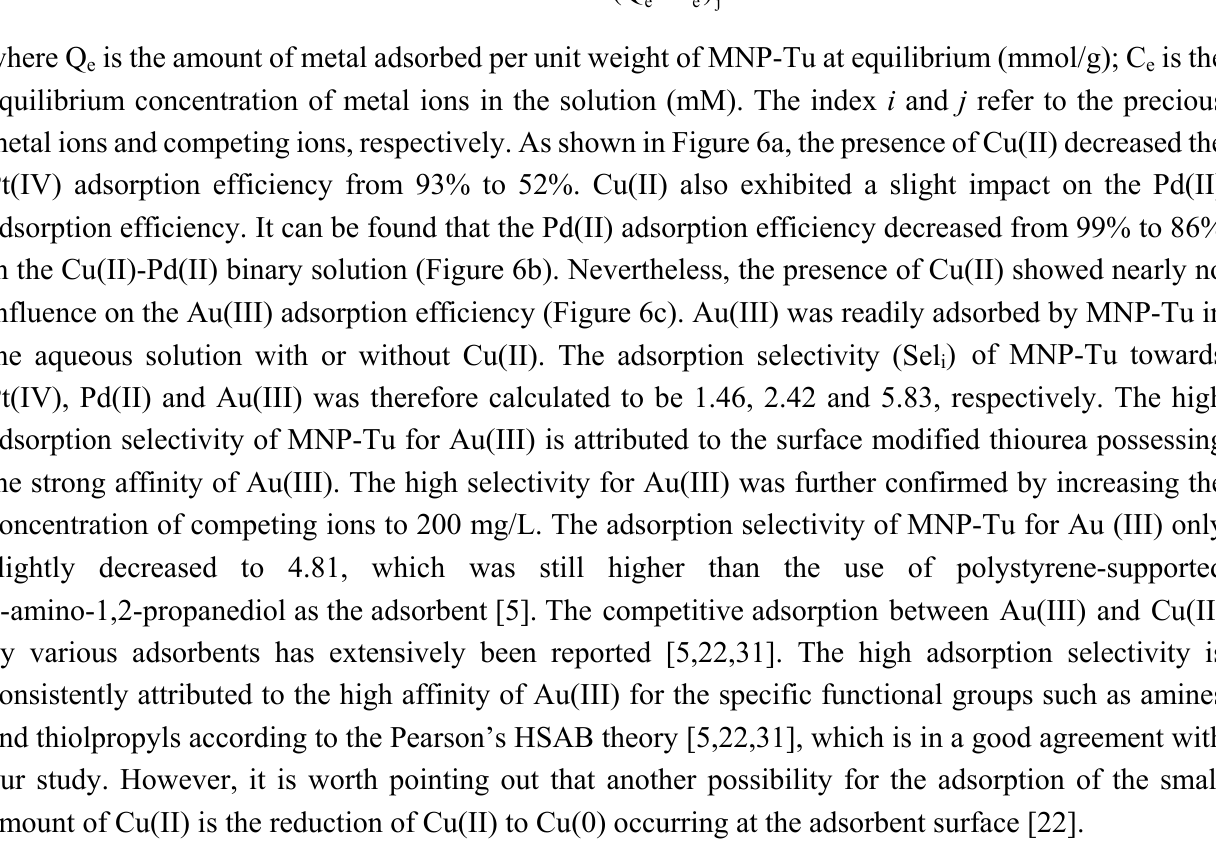
Figure 6. Effects of competing ions on the adsorption of ( a ) Pt(IV), ( b ) Pd(II) and ( c ) Au(III) at